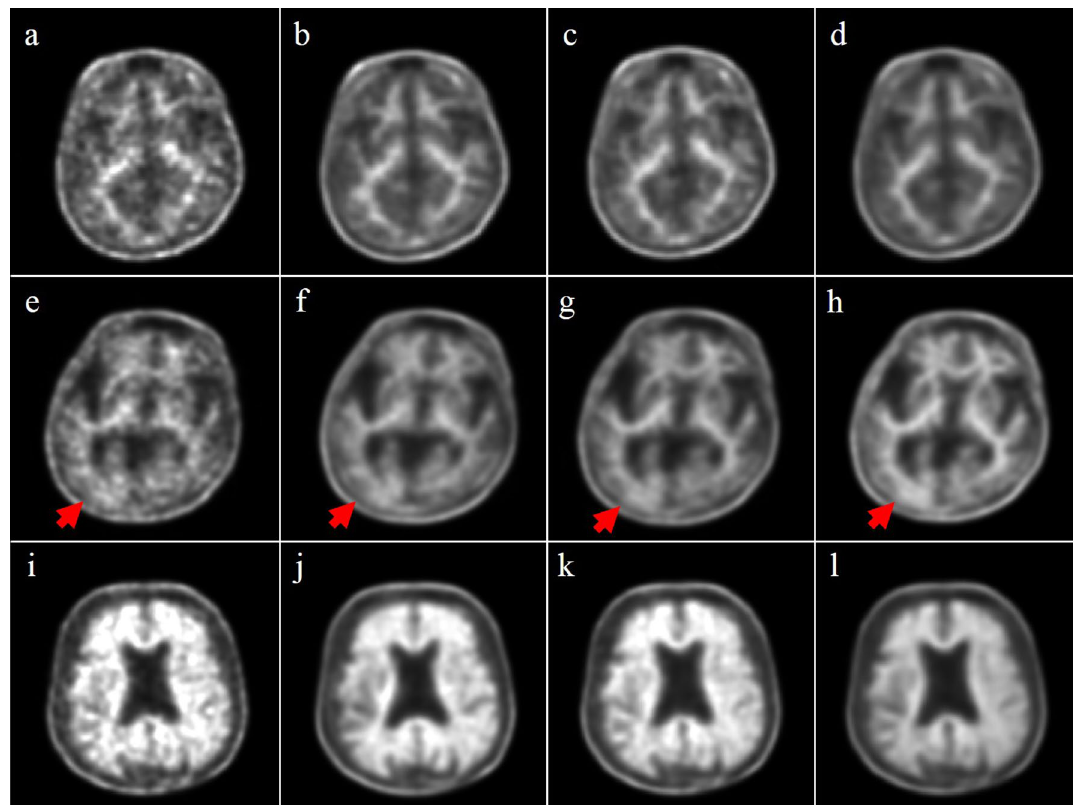
Figure 2. The input and output of PET images (upper row, BAPL 1; middle row, BAPL 2; lower row, BAPL 3). PET 2m image (input image) is very noisy and the image quality is poor ( a , e , i ). The ground truth with 20-min scanning ( b , f , j ) and synthetic PET images generated from the proposed deep learning ( c , g , k ) and the U-net ( d , h , l ) are shown. The synthetic PET image generated from our model is better in reflecting the underlying anatomical details than is the PET image generated from the U-net. In the BAPL 2 case, a small positive lesion (red arrows, e – h ) is equivocal in the PET 2m image ( e ), but clearly shown in sPET 20m image ( g ) as in PET 20m image ( f ).